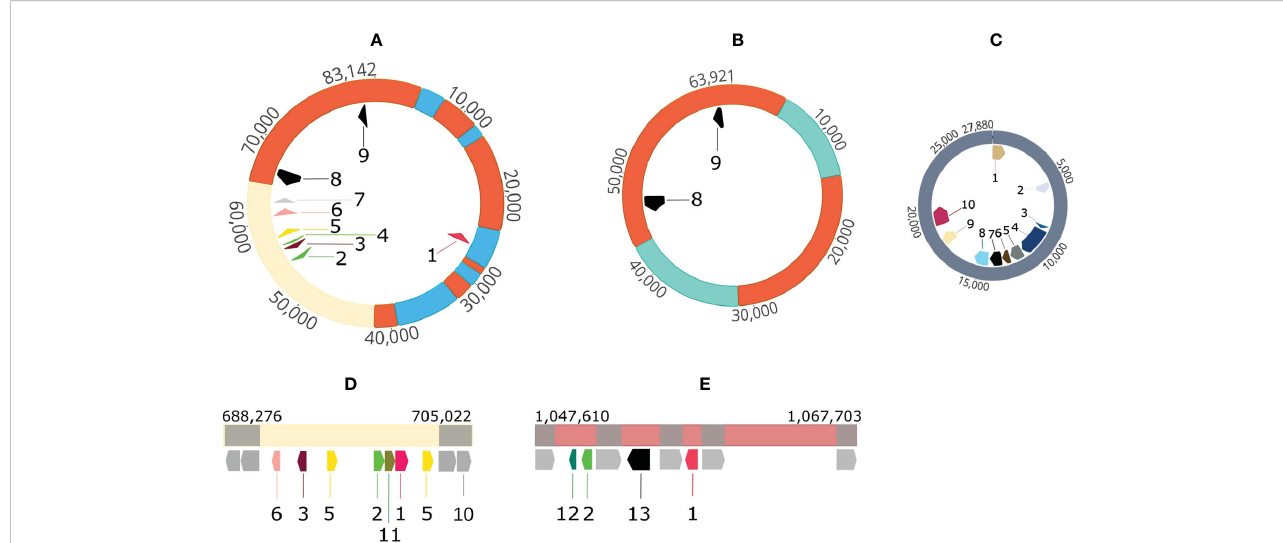
FIGURE 4 Visualization of plasmids and ARG-carrying mobile genetic elements in A. butzleri P1100 and P1200. (A) P1200 plasmid 83 kb 1 streptomycin 3 ’’ - O - adenylyltransferase/spectinomycin 9- O -adenylyltransferase gene, 2: aminoglycoside 6-adenylyltansferase gene, 3: chloramphenicol acetyltransferase gene, 4: aminoglycoside 6-adenylyltransferase gene, 5: ermB gene for 23S rRNA (adenine(2058)- N (6))-methyltransferase Erm(B)- RRNA (Adenine- N (6)-) -methyltransferase, 6: ant (6)-Ia aminoglycoside nucleotidyltransferase ANT(6)-Ia gene, 7: aph (3)-IIIa 3-aminoglycoside O -phosphotransferase type IIIa Aph(3)-IIIa gene, 8: tetracycline resistance protein gene tetM , 9: tetracycline resistance MFS ef fl ux pump gene tetH ; (B) P1100 plasmid 63 kb 8: tetracycline resistance protein gene tetM , 9: tetracycline resistance MFS ef fl ux pump gene tetH ; (C) P1100 pVir-like plasmid 27 kb 1: plasmid partitioning protein gene parB , 2: mpr4 , zinc metalloproteinase Mpr protein gene, 3: virB2 , 4: virB4 , 5: virB6 , 6: virB8 , inner membrane protein forms channel for type IV secretion of T-DNA complex, 7: virB9 outer membrane and periplasm component of type IV secretion of T-DNA complex, 8: virB10 inner membrane protein of type IV secretion of T-DNA complex, 9: virB11 10: virD4 , ATPase required for T-DNA transfer; (D) P1100 1 st mobile genetic element 1: streptomycin 3 ’’ - O -adenylyltransferase/spectinomycin 9- O -adenylyltransferase gene, 2: aminoglycoside 6-adenylyltansferase gene, 3: chloramphenicol acetyltransferase gene, 5: ermB gene for 23S rRNA (adenine(2058)- N (6))-methyltransferase Erm (B)- RRNA (Adenine- N (6)-) -methyltransferase, 6: ant (6)- Ia aminoglycoside nucleotidyltransferase ANT(6)-Ia gene, 10: mobile element protein gene, 11: sat-4 streptothricin acetyltransferase gene; (E) P1100 2 nd mobile genetic element 1: streptomycin 3 ’’ - O -adenylyltransferase/spectinomycin 9- O -adenylyltransferase gene, 2: aminoglycoside 6-adenylyltansferase gene, 12: ble bleomycin resistance protein gene, 13: tetracycline resistance MFS ef fl ux pump gene tetL; Color codes: orange: sequence identical regions of P1200-plasmid 83 kb and P1100 plasmid 63 kb, cream colored: sequence identical regions of P1200-plasmid 83 kb and P1100 1 st mobile genetic element grey: mobile element protein genes other colors: indicate unique sequence